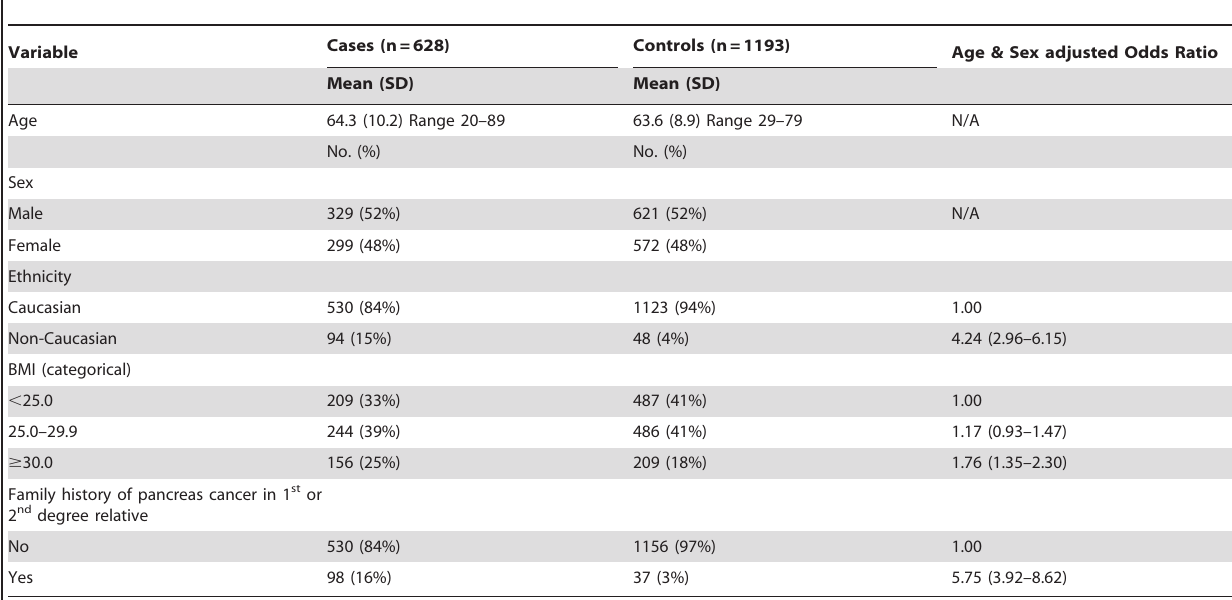
Table 2. Distribution of pancreatic cancer cases, controls and odds ratios for selected subject characteristics.